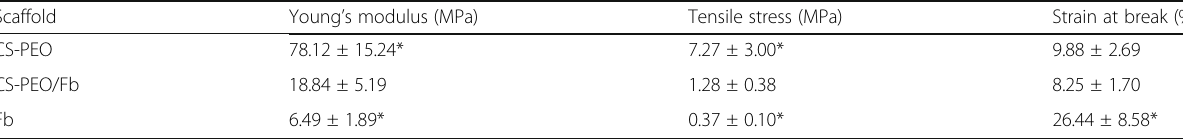
Table 1 Uniaxial tensile properties of electrospun scaffolds ( n = 10) Scaffold